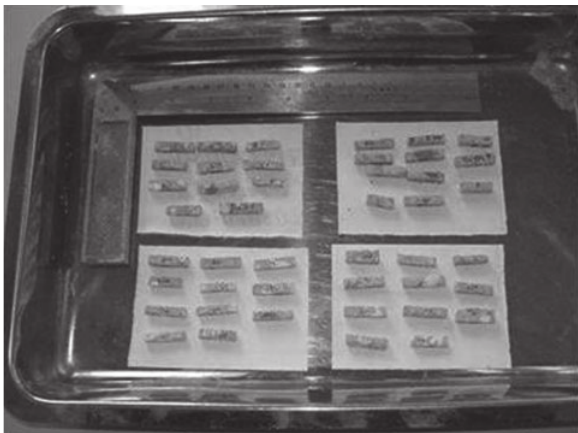
Figure 4 Prepared specimens for thermal expansion measurements.